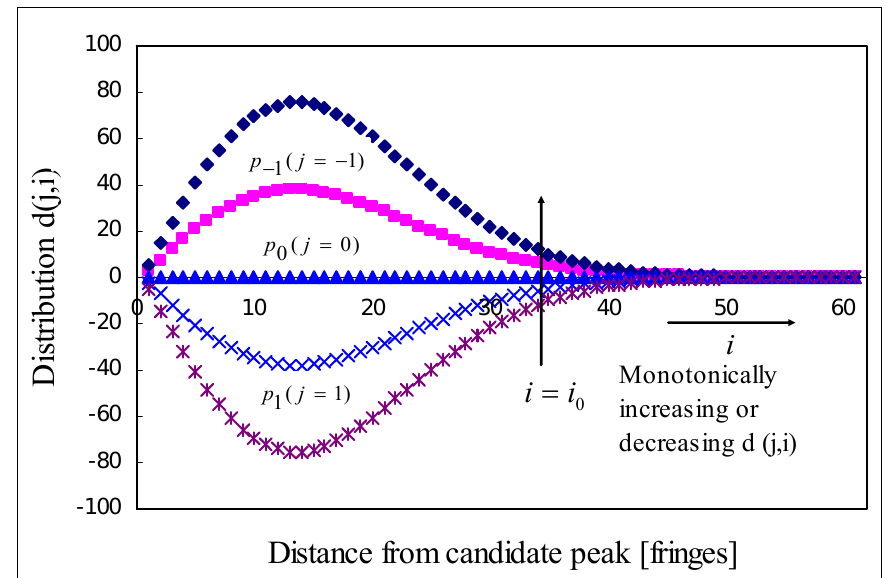
Figure 3 . Example of distribution d j i ( , ) for noise free cross-correlation i n ( )